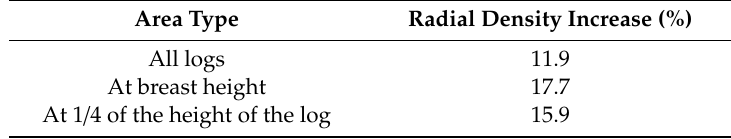
Table 9. Radial density increase (in the juvenile wood zone) on the cross-section of the birch log.